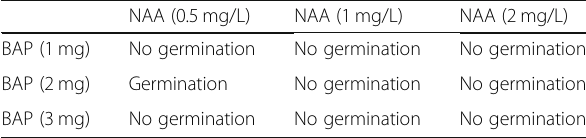
Table 1 Effect of BAP/NAA on gemmae germination NAA (0.5 mg/L)